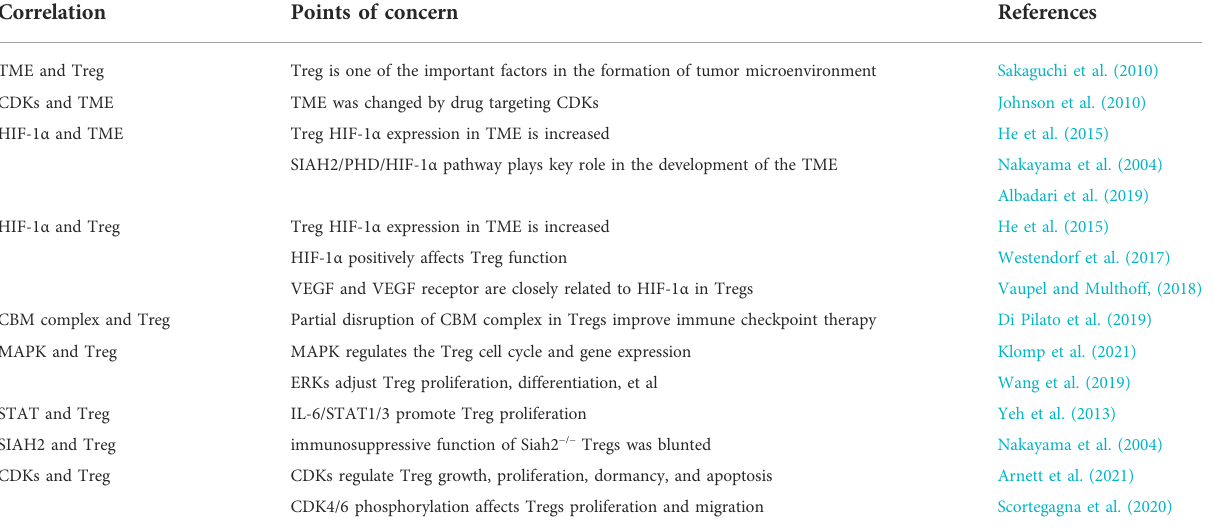
TABLE 1 Points of concern between TME, Treg, CDKs, HIF-1 α , CBM, MAPK, SIAH2 and